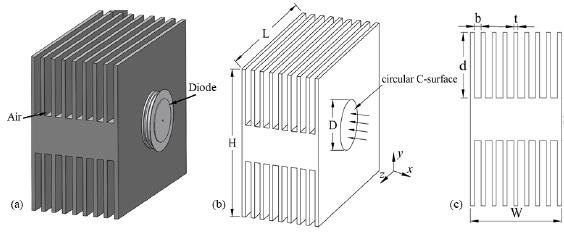
Fig. 3. Geometric parameters of the diode fin radiator: (a) 3D schematic diagram of the diode radiator; (b) projection of inlet direction; (c) simplified radiator heating